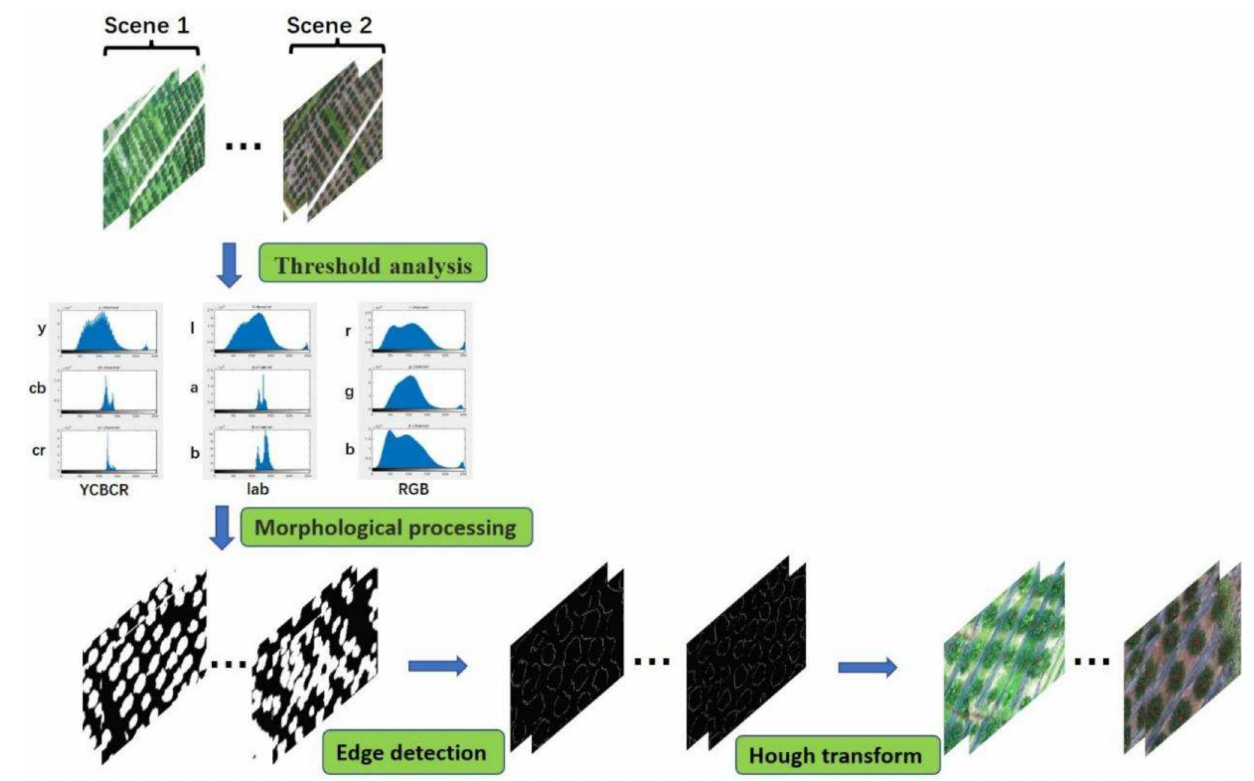
Figure 6. Flow chart of citrus tree detection based on Hough